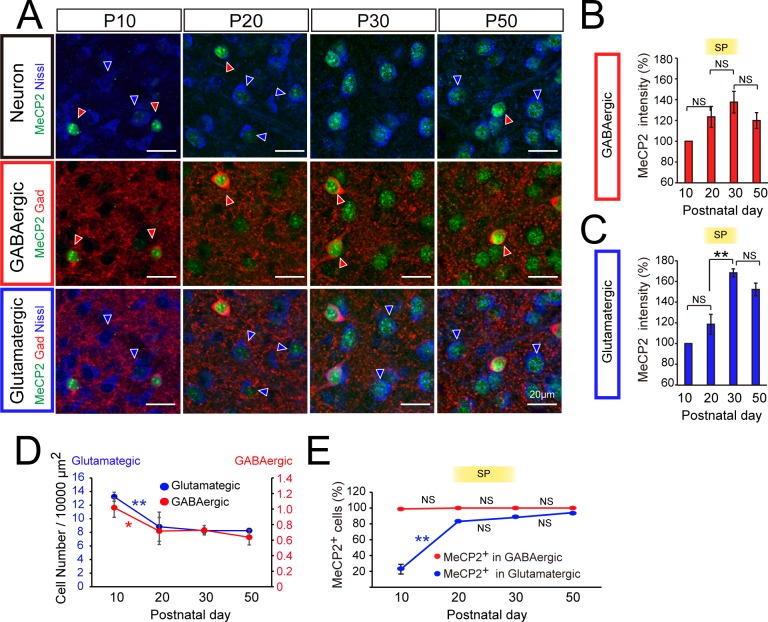
MeCP2 expression in excitatory versus inhibitory cells of the developing dLGN.(A) Identification of MeCP2-immunopositive cells (green) in the dLGN during development. Glutamatergic means GAD- / Nissl+ cells and GABAergic means GAD+ / Nissl+ cells. Red arrowheads, GABAergic neurons; blue arrowheads, glutamatergic neurons. Scale bar, 20 μm. (B) Changes in MeCP2-immunofluorescence intensity in GABAergic neurons during development. SP, sensitive period. P20: 123.4% ± 10.0% vs. P30: 137.6% ± 10.4%, P > 0.05. Statistical analysis for each developmental period was performed using the Steel-Dwass test. P10: 98 cells for 5 animals, P20: 56 cells for 6 animals. P30: 61 cells for 6 animals. P50: 44 cells for 5 animals. (C) Changes in MeCP2-immunofluorescence intensity in glutamatergic neurons during development. SP, sensitive period. P20: 118% ± 9.6% vs. P30: 168.3% ± 3.8%, **P < 0.01; Statistical analysis for each developmental period was performed using the Steel-Dwass test. NS, not significant. P10, 645 cells for 5 animals, P20: 738 cells for 6 animals. P30: 774 cells for 6 animals. P50: 463 cells for 5 animals. (D) The number of GABAergic and glutamatergic neuron in 10000 μm2 decreased between P10 and P20. GABAergic neuron, P10: 1.01 ± 0.12 vs P20: 0.72 ± 0.17, *P < 0.05. Glutamatergic neuron, P10: 13.23 ± 0.66 vs. P20: 8.82±2.1, **P < 0.01. Statistical analysis for each developmental period was performed using the Steel-Dwass test. N = 9 slides for 3 animals. (E) Proportion of MeCP2+ cells increased among glutamataargic neurons (blue), but not among GABAergic neurons (red), before entering the SP. Glutamatergic neurons, P10: 22.8% ± 6.2% vs. P20: 83.1% ± 2.2%, **P < 0.01; Statistical analysis for each developmental period was performed using the Steel-Dwass test. NS, not significant. N = 9 slides for 3 animals.